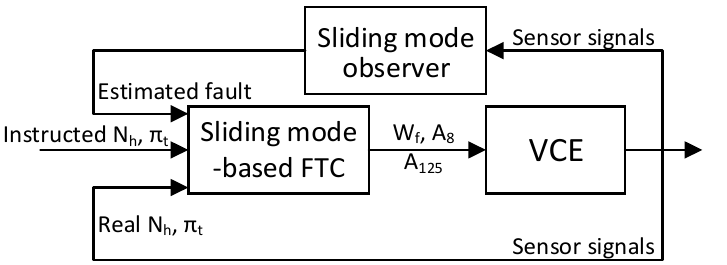
Figure 2. Structure of the actuator fault tolerant control design.